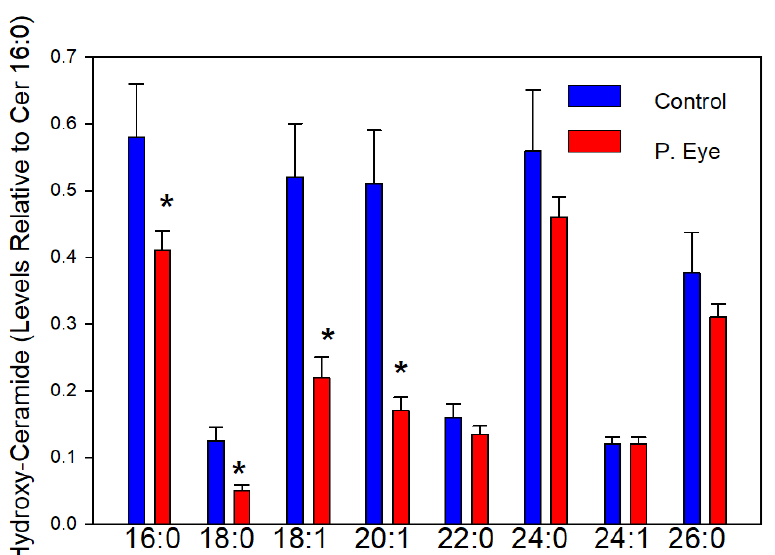
Figure 2. Tear film levels of hydroxy-ceramides (Hydroxy-Cer d18:1/x) in controls and cows with pink eye (P. Eye). The peak intensities of individual hydroxy-ceramides are expressed as a ratio of the peak intensity of ceramide d18:1/16:0. *, significant t -test statistics: 16:0 (0.023); 18:0 (0.014); 18:1 (0.020); 20:1 (0.0083).